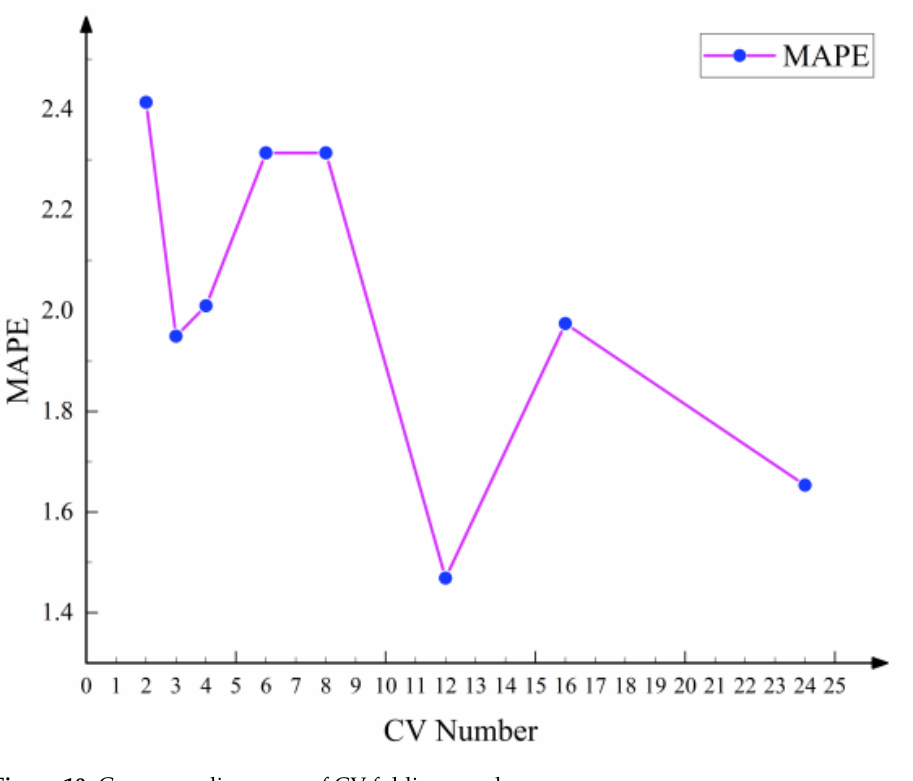
Figure 10. Corresponding error of CV folding number. Table 1. Comparison of method parameter